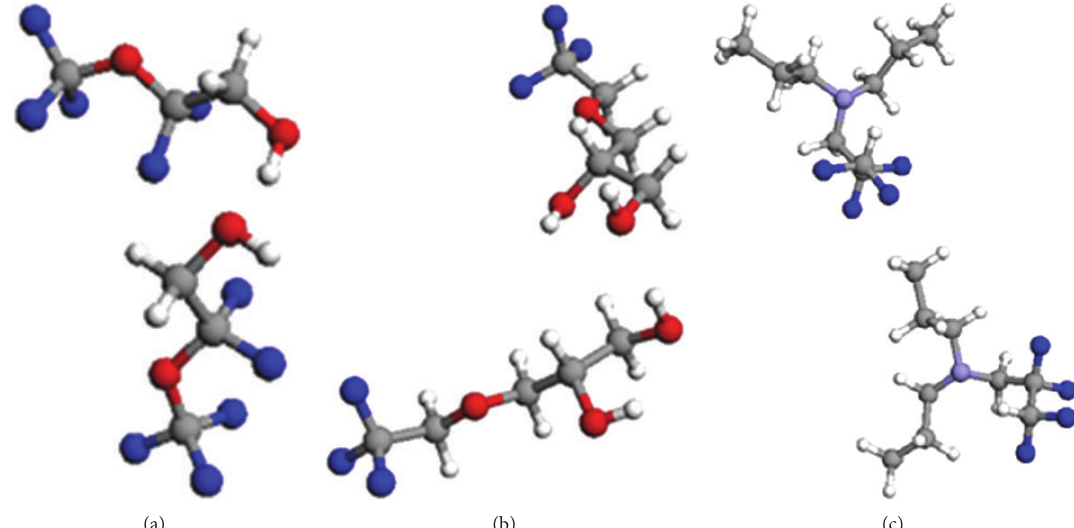
Figure 3: Pure relaxed lubricant dimers for (a) Z-dol, (b) Z-tetraol, and (c) DDPA. Red: oxygen, purple: nitrogen, blue: fluorine, grey: carbon, and white: hydrogen.